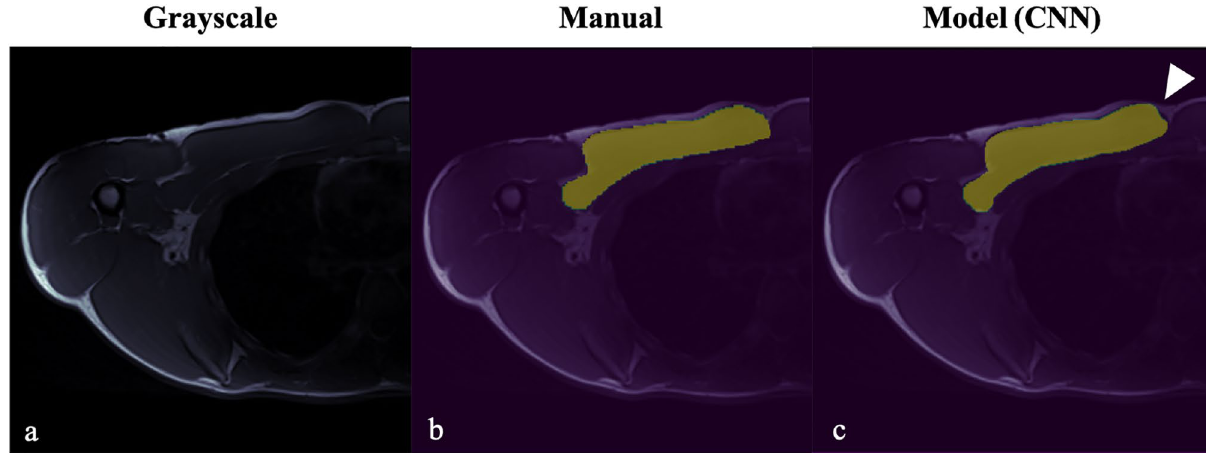
Figure 4. Example of accurate PM muscle segmentation using model B, with normal muscle appearance ( a ) grayscale axial T1 FSE image, ( b ) manual tracing, and ( c ) model prediction by CNN.